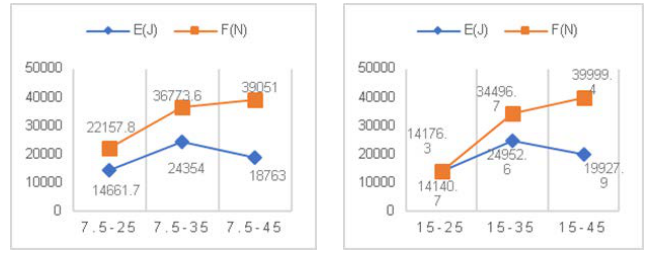
Fig. 7 Data at position 2 ‘waterfall inlet’